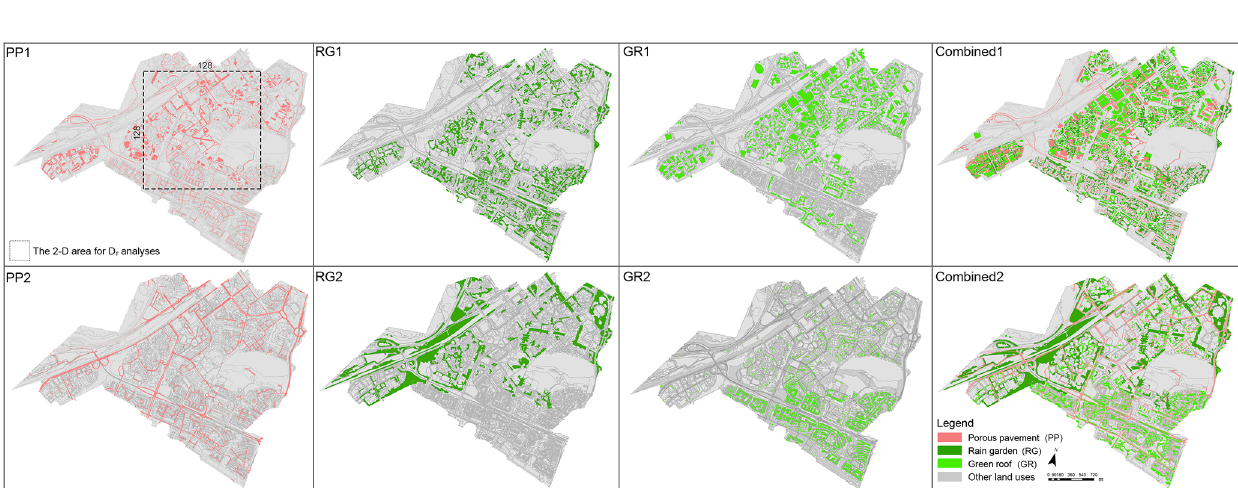
Figure 6. A total of two scenarios for each of NBS implementation, including porous pavement (PP1 and PP2), rain garden (RG1 and RG2), green roof (GR1 and GR2), and Combined1 and Combined2. The rectangular area in the PP1 scenario is the example area for applying fractal